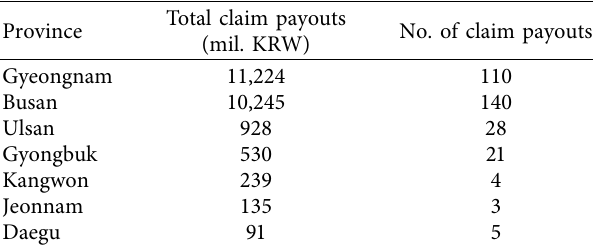
Figure 1: Typhoon Maemi: (a) track of typhoon and (b) distribution of losses. Table 1: Loss records per province from Typhoon